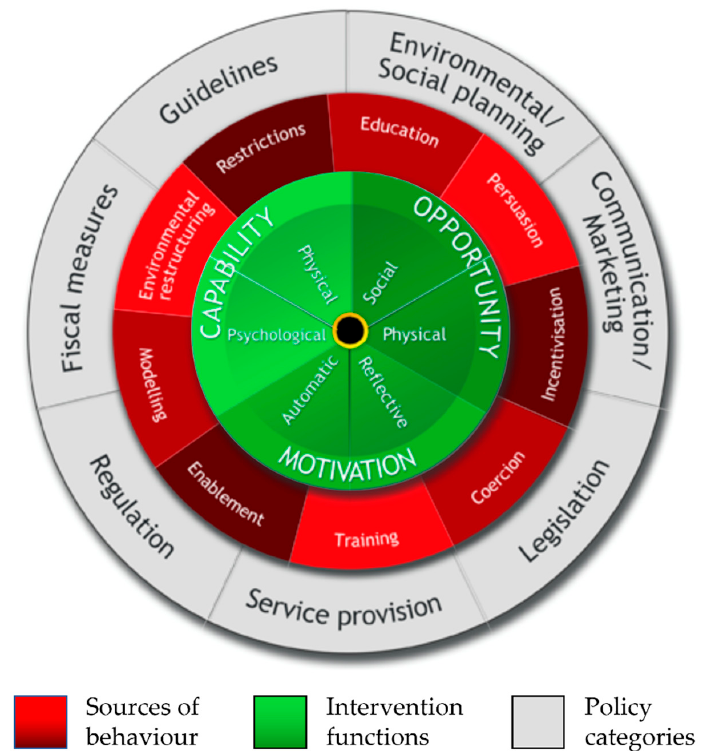
Figure 2. The original Behaviour Change Wheel, showing the three sources of behaviour, the nine intervention functions, and the seven policy categories. Reproduced with permission [33] from Michie, Atkins, and West (2014) [33].